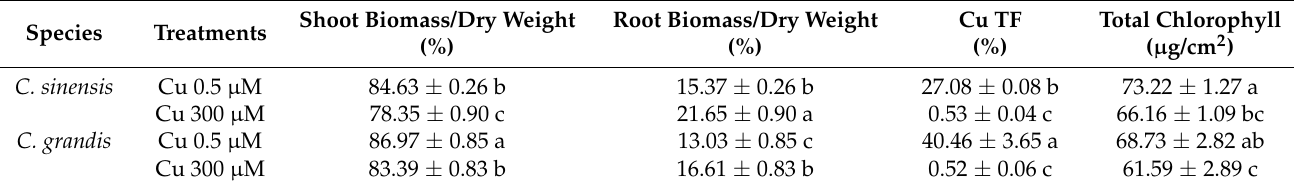
Table 1. The effects of excessive Cu on biomass distribution, Cu translocation factor (TF, defined as the ratio of Cu concentration in the leaves to the lateral roots) and total chlorophyll content of two citrus species. The values represent means ± SE of four replicates. Significant differences ( p ≤ 0.05) between treatments are indicated by different letters.